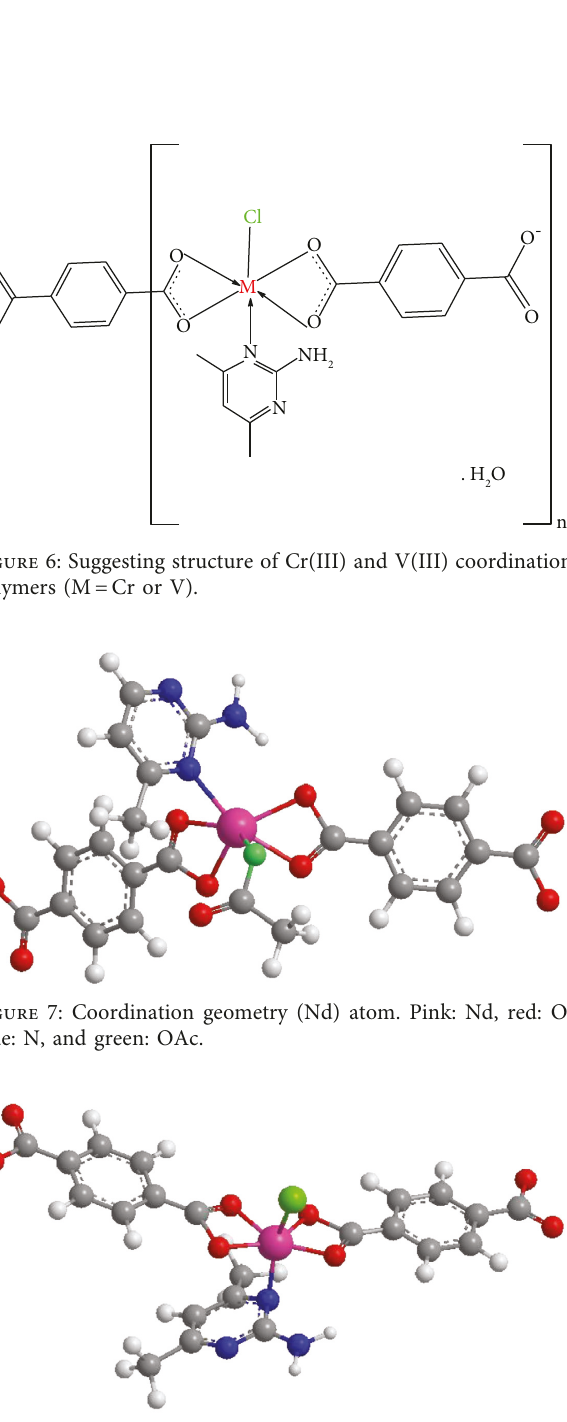
Figure 8: Coordination geometry around (Cr or V) atom. Pink: Cr or V, red: O, blue: N, and green: